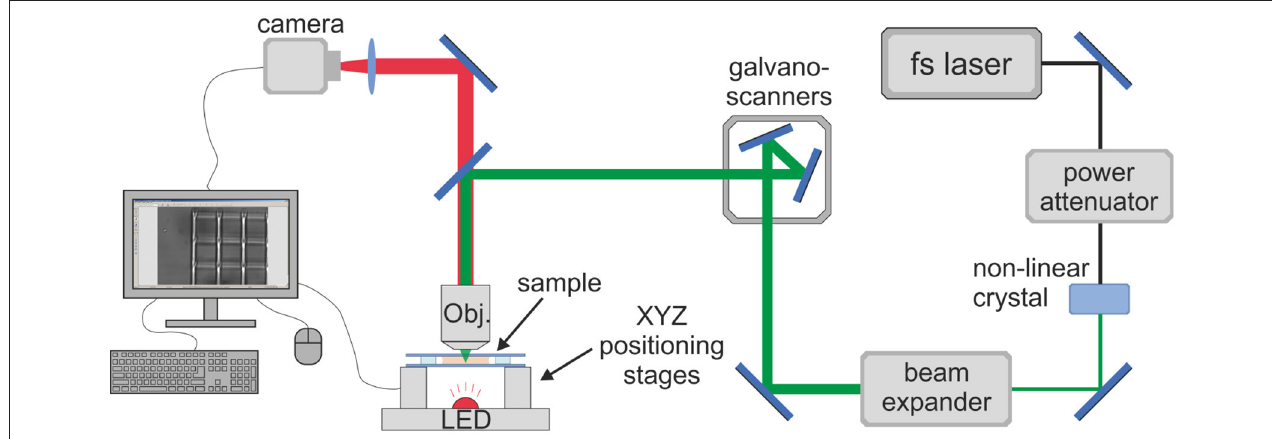
FIGURE 3 | Optical setup for DLW-2PP. Femtosecond laser beam is scanned inside the photo-sensitive material in a pre-defined trajectory by employing the synchronized movement of galvano-scanners and linear positioning stages. The whole process is monitored on the computer screen in real-time.